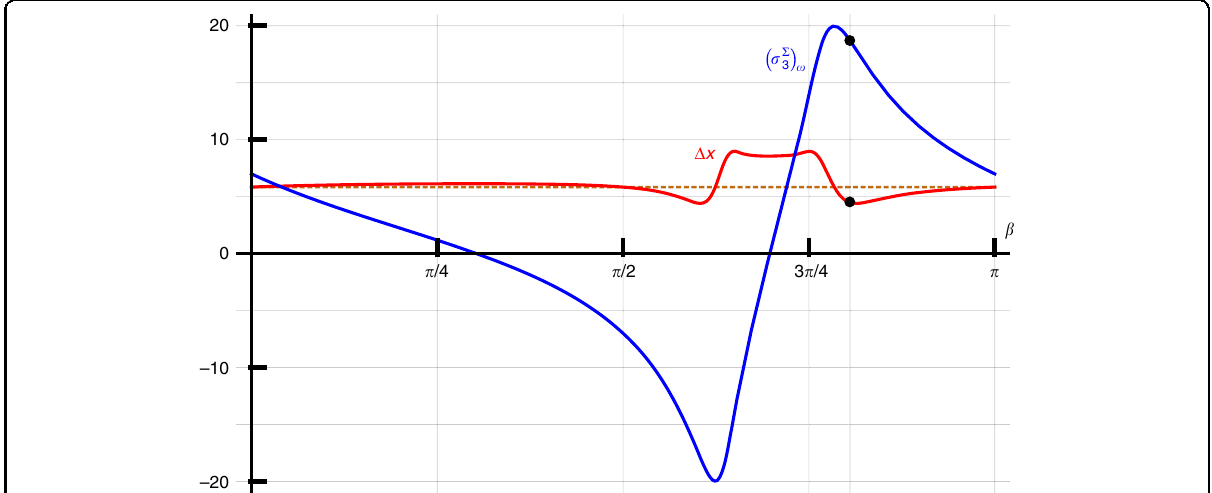
Fig. 3 Predicted weak value and pointer uncertainty. Predicted values for the WV ð σ Σ (solid blue line) and the fi nal pointer uncertainty Δ x (solid 3 Þ w red line) for n = 7, α = 0.62 and Δ = 5.84, as a function of β . The initial photon distribution width Δ is included as a dashed brown line. The two black 18 : 7 and Δ x = 4.5 obtained for β = 2.53, the parameters chosen for our experimental dots on the curves denote the ð σ Σ 3 Þ w ¼